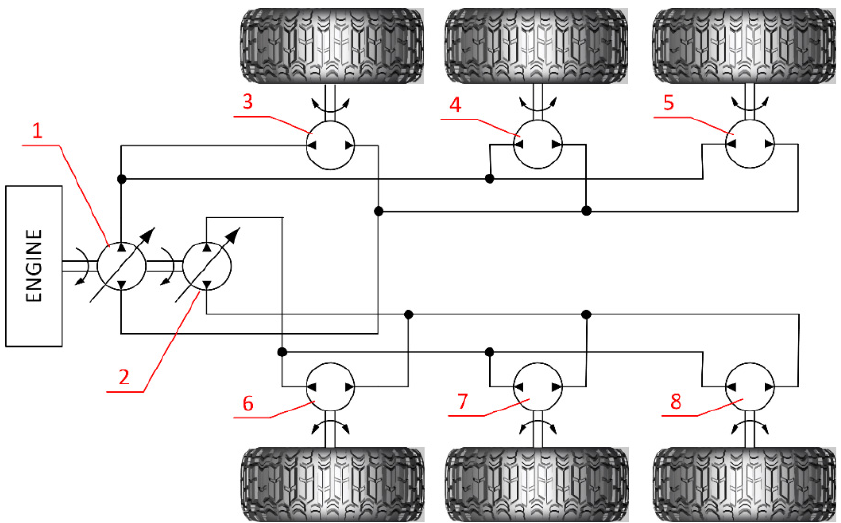
Figure 2. Main elements of the 6 × 6 robot hydrostatic drivetrain: 1, 2—variable displacement pumps; 3, 4, 5—robot left-side hydraulic motors; 6, 7, 8—robot right-side hydraulic motors [14].